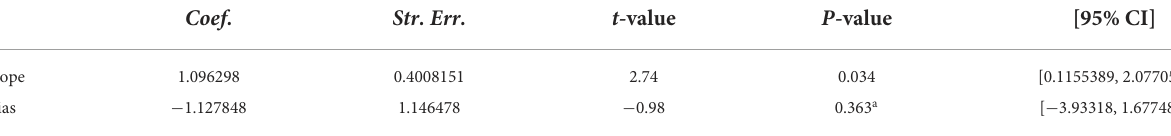
TABLE 3 Egger’s test for publication bias of meta-analysis on all studies.